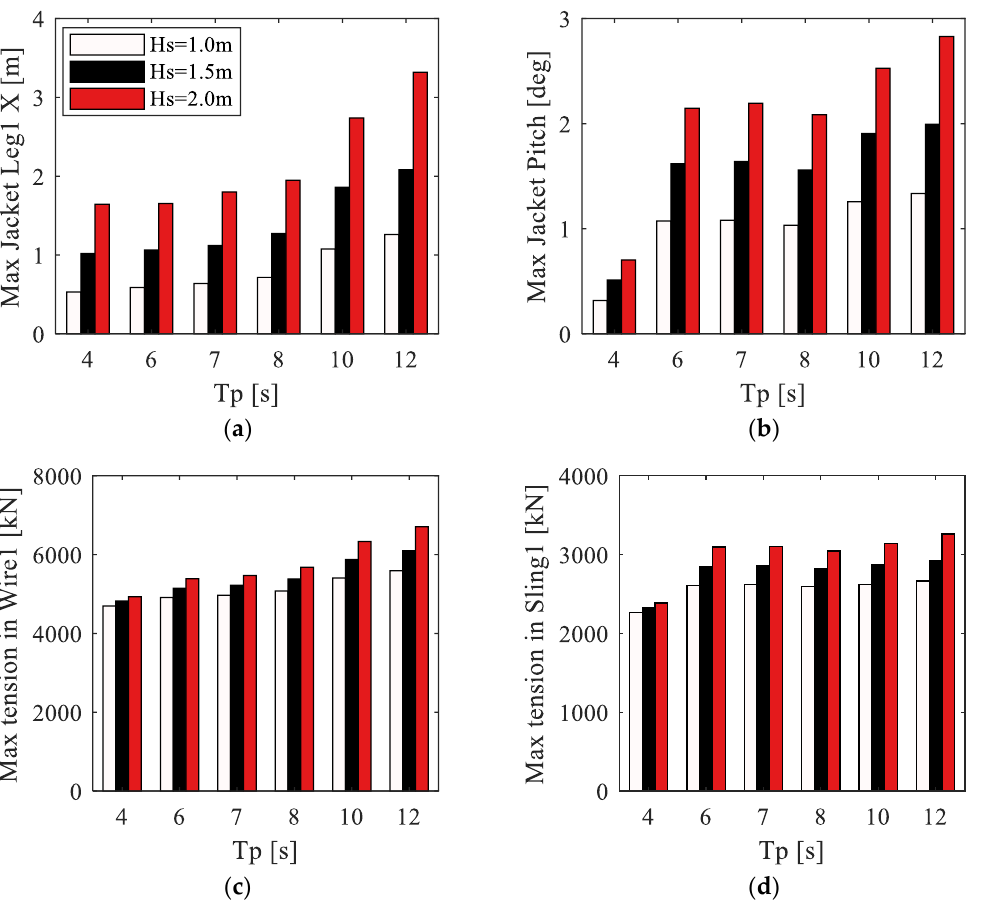
Figure 17. Extreme r esponses for several sea states (Dir = 180 deg, JL1-Z3). ( a ) Max motion of jacket leg1 X; ( b ) Max motion of jacket pitch; ( c ) Max tension of wire1; ( d ) Max tension of sling1.